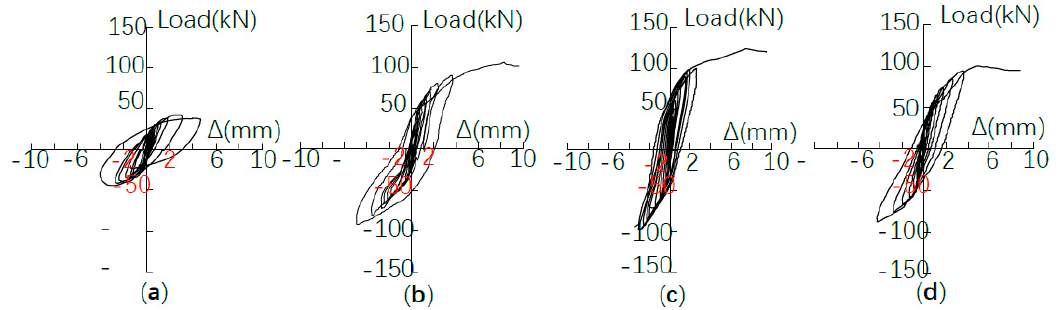
Figure 10. Hysteretic loops of the walls: ( a ) W1; ( b ) W1S; ( c ) W2; ( d ) W3.